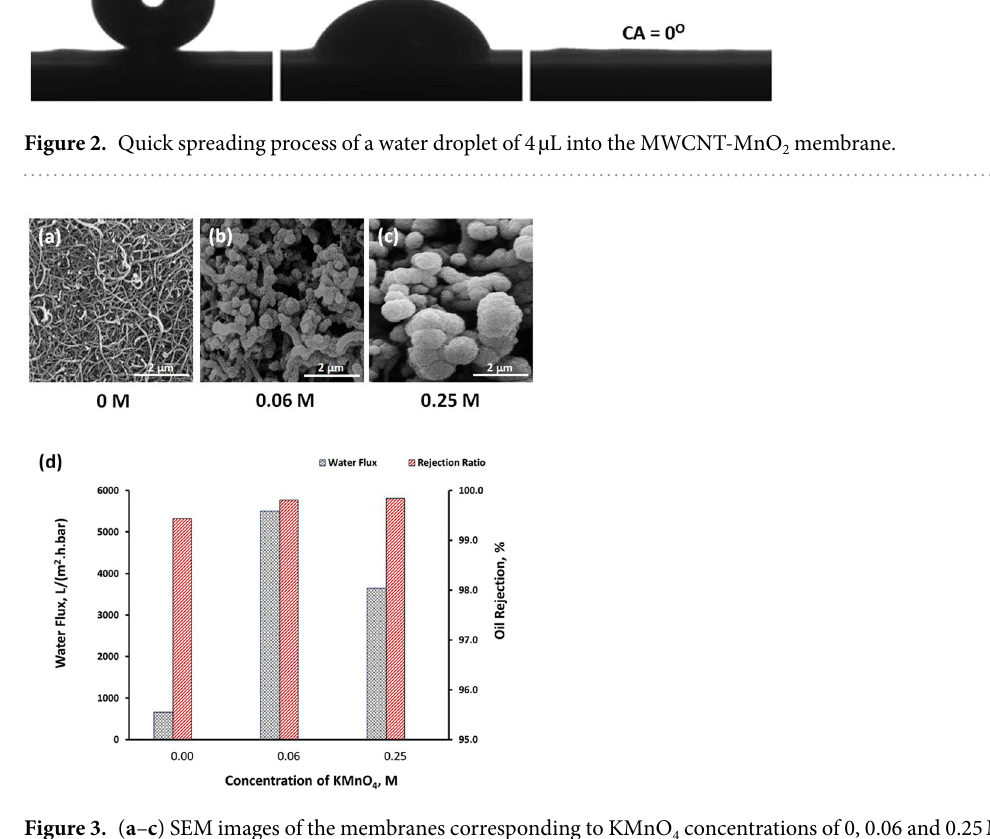
Figure 3. ( a – c ) SEM images of the membranes corresponding to KMnO 4 concentrations of 0, 0.06 and 0.25 M respectively at a fixed CNT concentration. ( d ) Water flux and permeate oil content of sunflower oil-in-water emulsion feed using similar